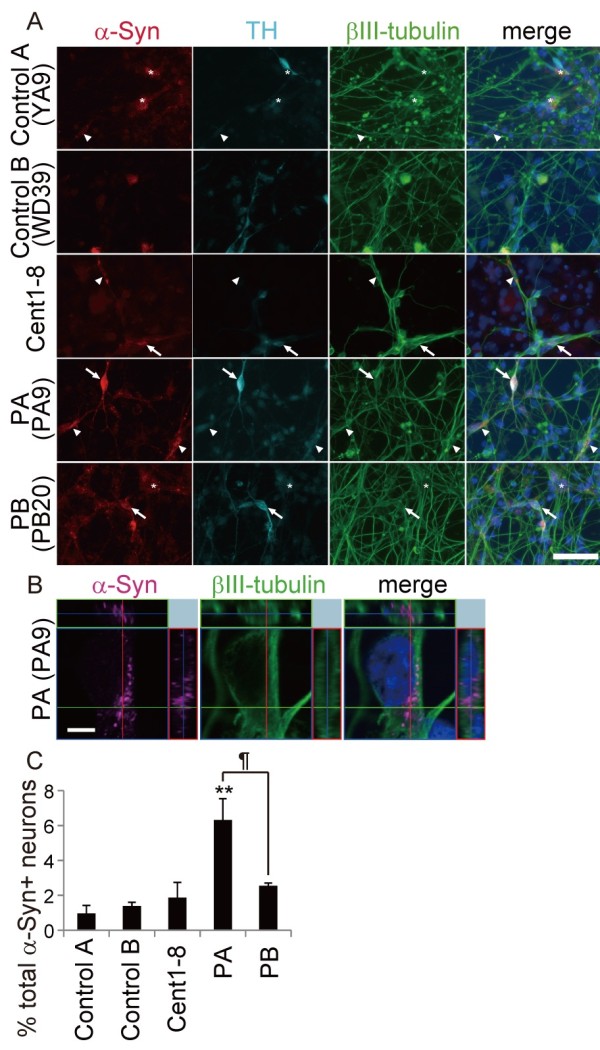
α-synuclein accumulation in PARK2 iPSC-derived neurons. (A–C) Triple labeling for α-synuclein (red), tyrosine hydroxylase (TH; cyan), and βIII-tubulin (green) along with Hoechst (blue) staining of control A (B7), control B (WD39), Cent1-8, and PARK2 (PA9 and PB20) iPSC-derived neurons. (A) Arrows indicate α-synuclein+/TH+/βIII-tubulin+ neurons; arrowheads indicate α-synuclein+/TH-/βIII-tubulin+ neurons. Note the presence of α-synuclein+/TH-/βIII-tubulin- non-neural cells (asterisks). (B) High magnification confocal projection image of an α-synuclein (magenta)/βIII-tubulin (green) double-positive PA9 iPSC-derived neuron. (C) The proportion of α-synuclein+/βIII-tubulin+ neurons relative to βIII-tubulin-positive neurons was significantly higher in PA (PA1, 9 and 22) iPSC-derived neurons than in control A (B7 and YA9), control B (WD39) and Cent1-8 iPSC-derived neurons. Scale bars: A, 50 μm; C, 5 μm. ** indicates P < 0.01; * and ¶ indicate P < 0.05 (Mann–Whitney U-test). Data represent the mean and SEM of at least three experiments for each group.